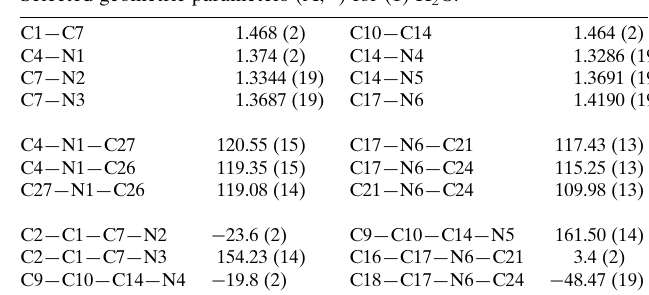
Table 2 Selected geometric parameters (A˚ , (cid:3) ) for (1) (cid:2) H 2 O.